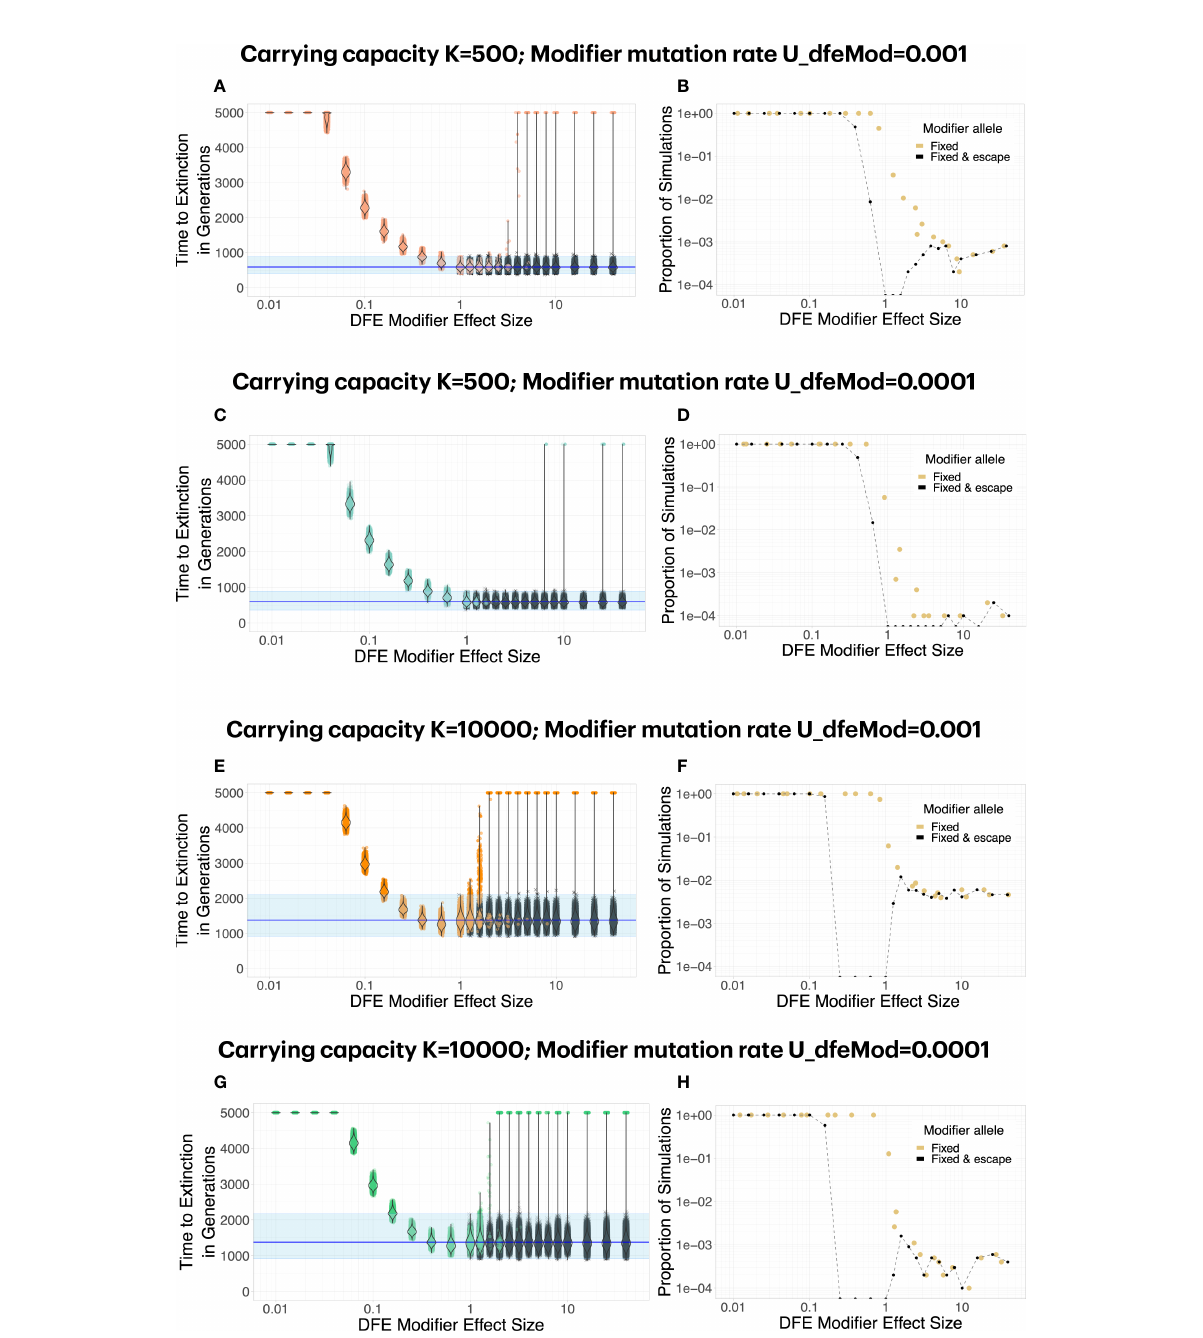
FIGURE 4 Both positive and negative DFE modi fi ers can lead to escape from mutational meltdown. Each dot in (A, C, E, G) represents a simulation run; simulations in which the mutation modi fi er was fi xed in the population are shown in color, whereas simulations in which the modi fi er did not invade are shown in gray. For positive DFE modi fi ers (effect size f dfeMod <1, i.e., the modi fi er makes deleterious mutations less deleterious), modi fi er alleles invade and fi x reliably, but a large effect size f dfeMod <1 is necessary to lead to successful escape from mutational meltdown (i.e., survival for 5000 generations). For negative DFE modi fi ers (effect size f dfeMod >1, i.e., the modi fi er makes deleterious mutations more deleterious), modi fi er alleles invade and fi x rarely, especially when the mutation rate to the modi fi er is low (D, H) . Interestingly, although a negative DFE modi fi er initially tends to have a deleterious fi tness effect on the lineage it carries, its escape probability increases with the carrying capacity (compare B , D versus F, H ), unlike what is expected for a deleterious mutation. Each parameter combination was simulated 10000